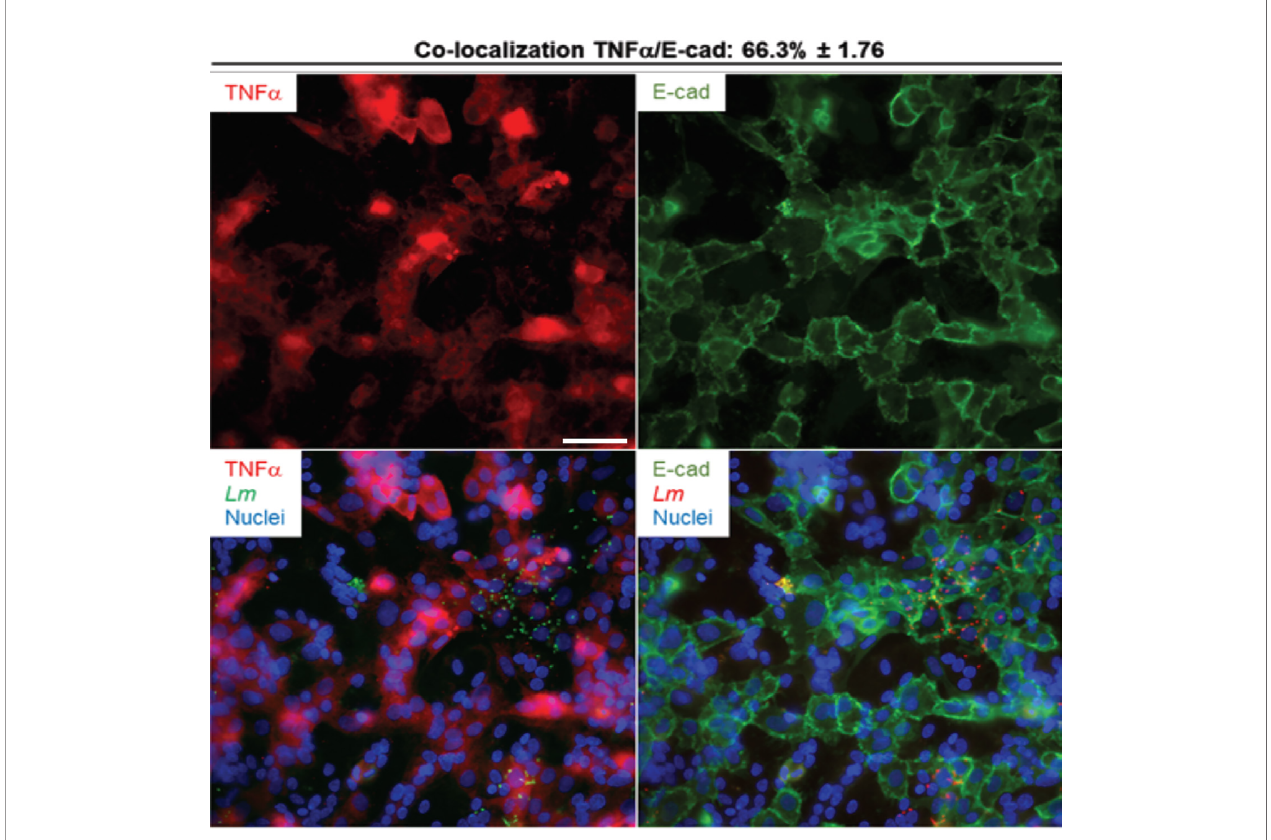
FIGURE 7 | TNF a colabeling with E-cadherin in infected primary trophoblasts. PHT were infected with p actA -RFP L. monocytogenes (MOI 1) for 5 h using the same experimental procedure as the RNAseq infection experiments. Cells were fi xed, permeabilized and labeled for TNF- a (rabbit primary Ab and secondary Ab-Alexa Fluor 647) and for E-cadherin (mouse primary Ab and secondary Ab-Alexa Fluor 488). At least thirty fl uorescent images were randomly acquired with the 40X objective. Representative images are from one experiment. Scale bar = 50 µm. The MetaMorph software was used to measure the percent colocalization between TNF a and E-cadherin, the average colocalization ± SEM is indicated at the top of the